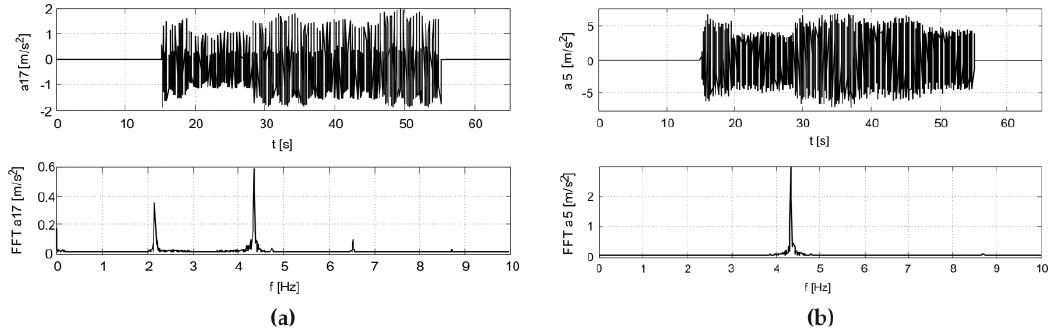
Figure 21. Results of numerical simulations from the excited vibrations caused by jumping fans (Labado dance): ( a ) girder, ( b ) roof .